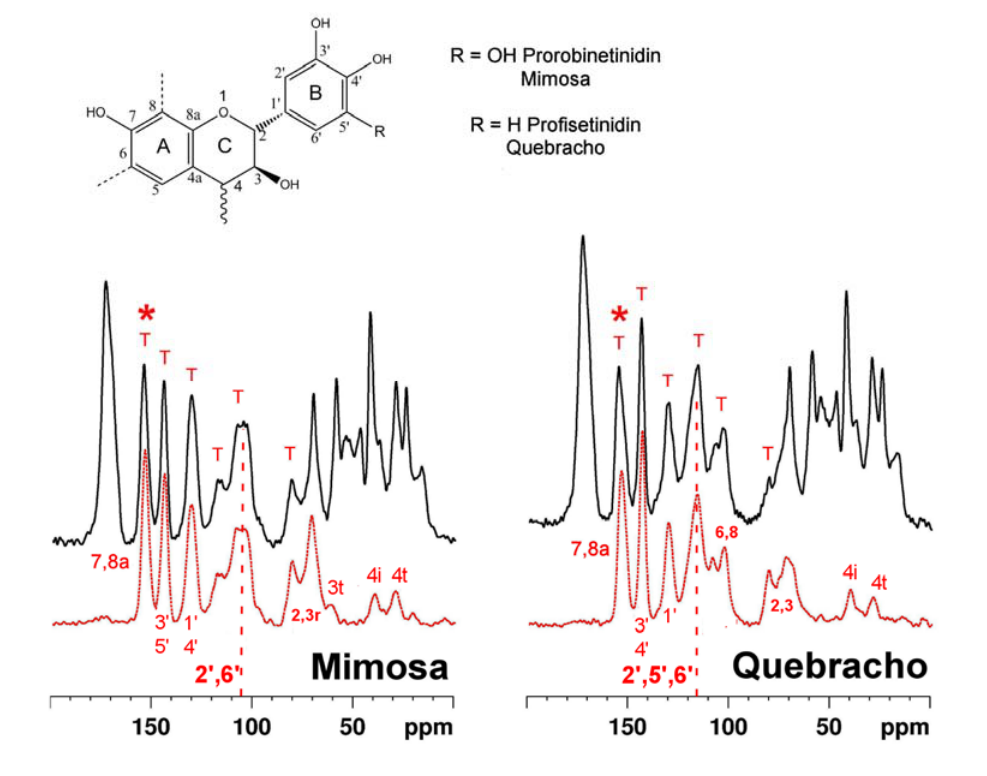
Figure 1. Solid state 13 C CP-MAS spectra of leather (the black solid traces) tanned with tannins from mimosa (left) and quebracho (right) . These are plotted above identically acquired spectra from the respective pure tannins (the red dotted traces) . Also shown is a generic structure of the repeating flavonoid units predominating in each tannin; usually it is the A-ring 8, and 6, carbons (dashed bonds) which attach to the C-ring 4-carbon atom of a neighbour flavonol. In the spectra of the leather, tannin signals which are well resolved from collagen signals, and therefore reliable “fingerprints” of the tannin type used in the tanning process, are marked “T”. The vertical dashed lines highlight the envelope of signals the intensity of which is diagnostic of mimosa tanning (B-ring 2’ and 6’ carbon atoms at 105 ppm) and quebracho tanning (B-ring 2’, 5’ and 6’ carbon atoms at 115 ppm). Asterisks highlight signals from the A-ring 7 and 8a carbons indicative of condensed polyflavonoid tannins and their presence in leather. Some other assignments are shown; the suffixes “t” and “i” respectively indicate signals from carbon atoms at the terminus of, or internal to, the polyflavonol